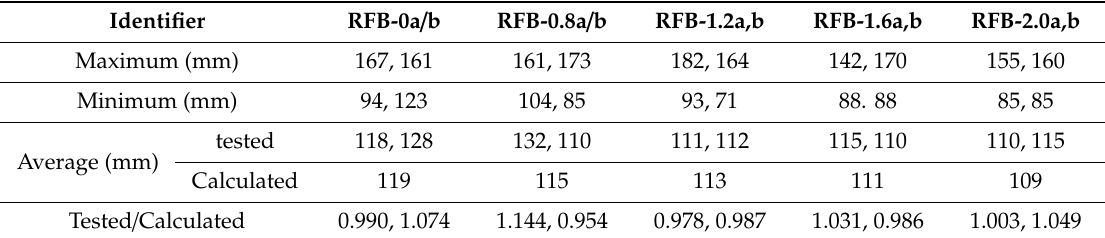
Table 4. Test results of crack spacing compared with the calculation at normal serviceability.